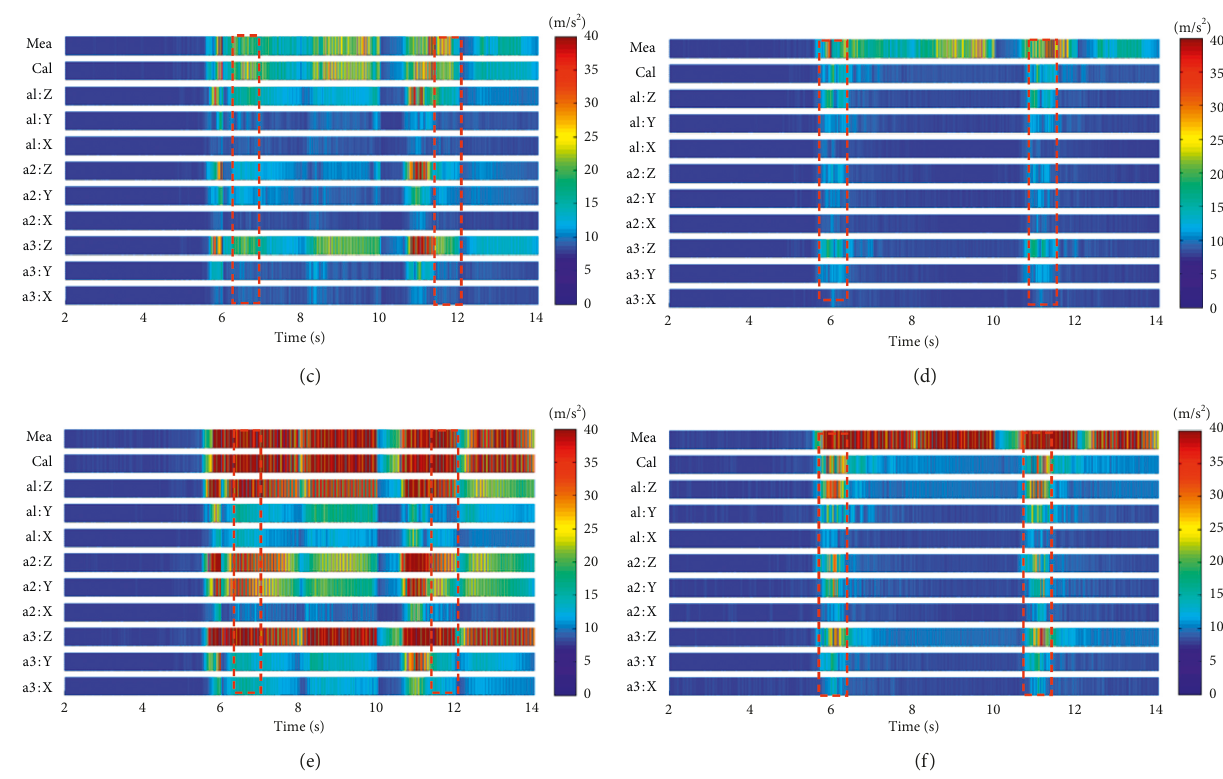
Figure 8: Time-domain vibration contribution analyses calculations using M-2 and M-1. Mea: measurements; Cal: calculation; a 3: Y refers to the path of point C ( a )3 ( ω ) along with Y direction. (a) O ( a )1 ( ω )- Z -contribution via M-2 method. (b) O ( a )1 ( ω )- Z -contribution via M-1 method. (c) O ( a )2 ( ω )- Z -contribution via M-2 method. (d) O ( a )2 ( ω )- Z -contribution via M-1 method. (e) O ( a )3 ( ω )- Z -contribution via M-2 method. (f) O ( a )3 ( ω )- Z -contribution via M-1 method.